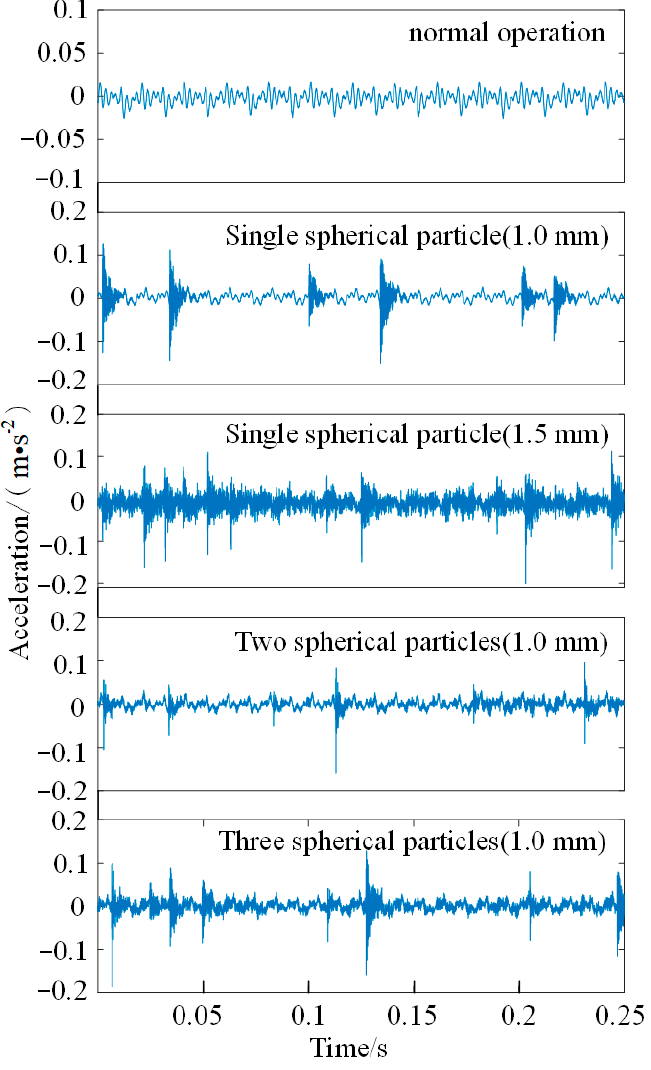
Figure 5. Vibration signals of different operating states.